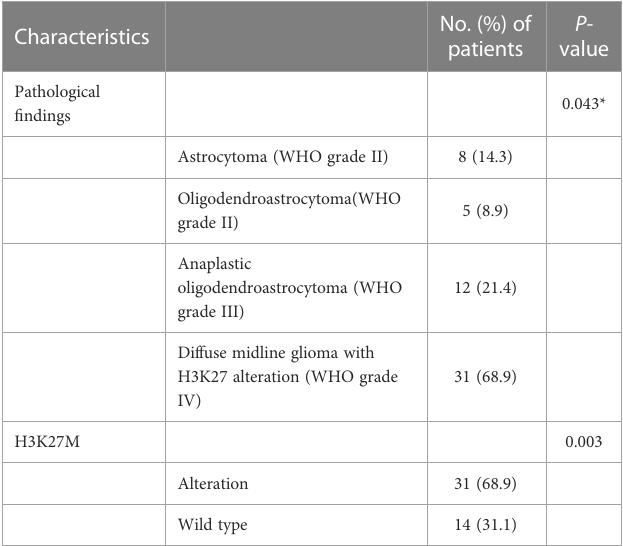
TABLE 2 Pathological parameters correlated with OS of 56